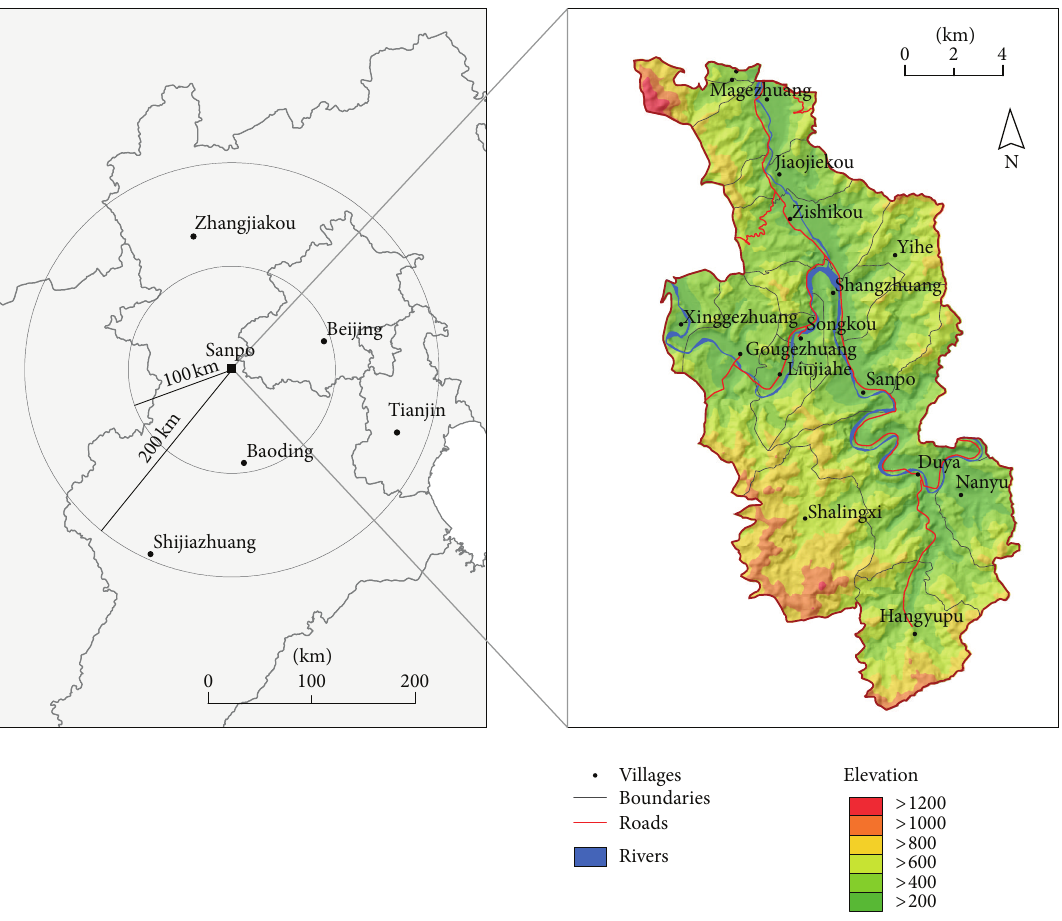
Figure 1: Location of study